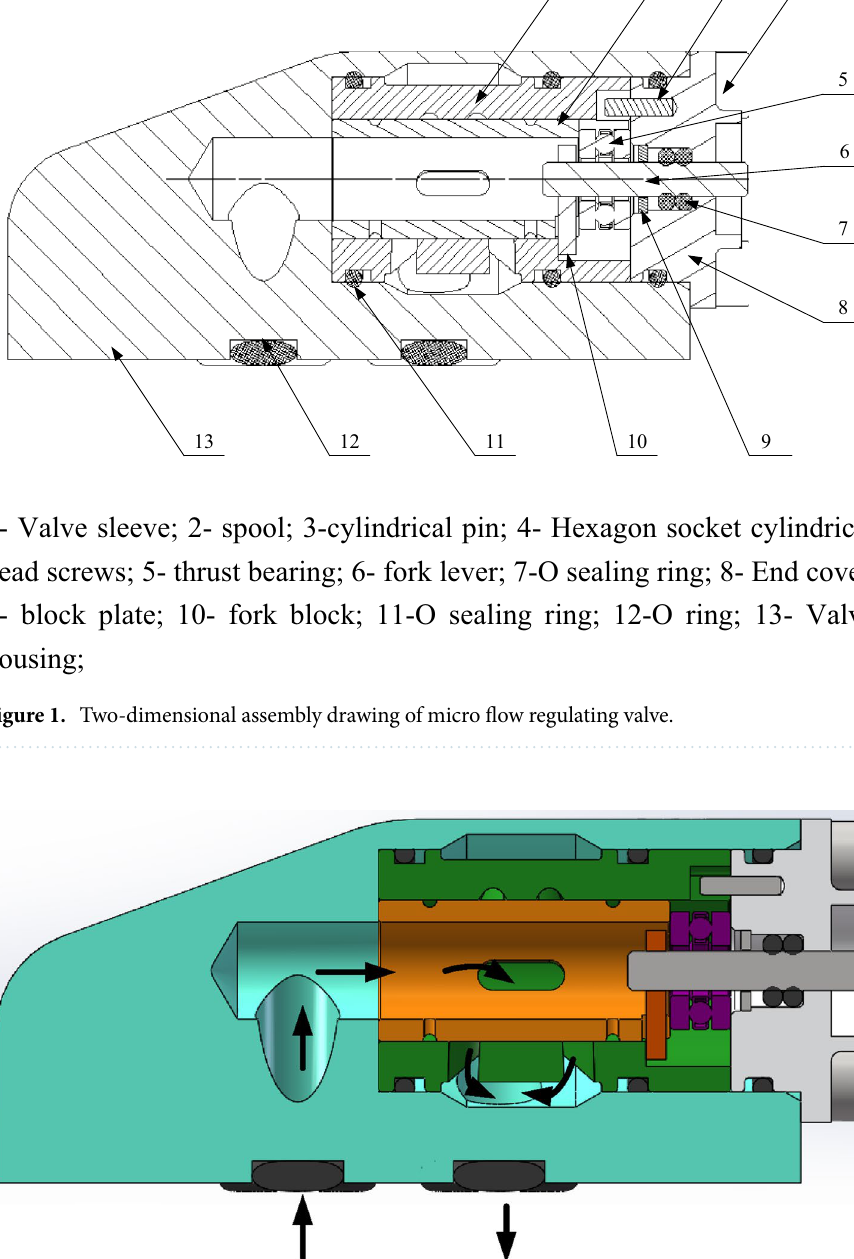
Figure 2. Oil flow diagram of micro flow control